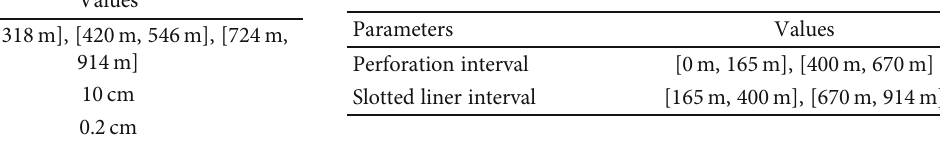
Figure 9: In fl ow rate distribution of segregated well completion at di ff erent times. Table 5: Parameters of di ff erent well